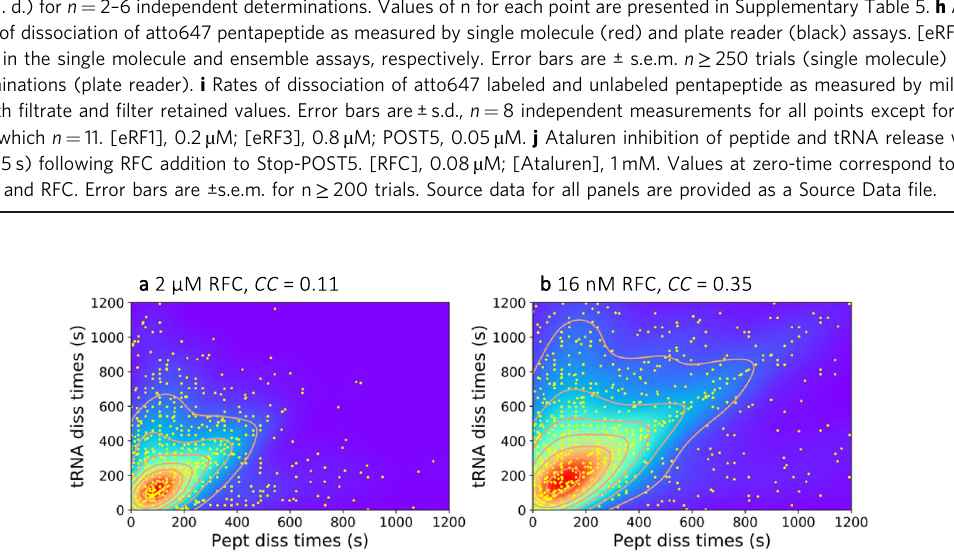
Fig. 5 Scatter plots of peptide and tRNA dissociation times. Each point represents dissociation times from an individual ribosome. CC is correlation coef fi cient. a 2 µ M RFC. b 16 nM RFC. Source data are provided as a Source Data fi